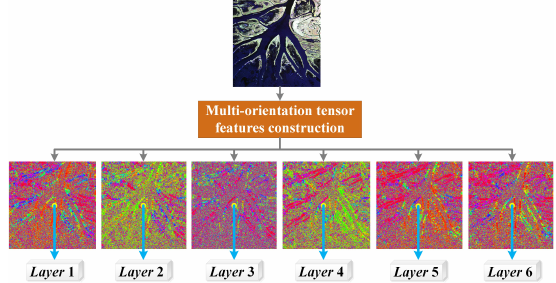
Figure 2 . Construction process of multi-orientation tensor feature